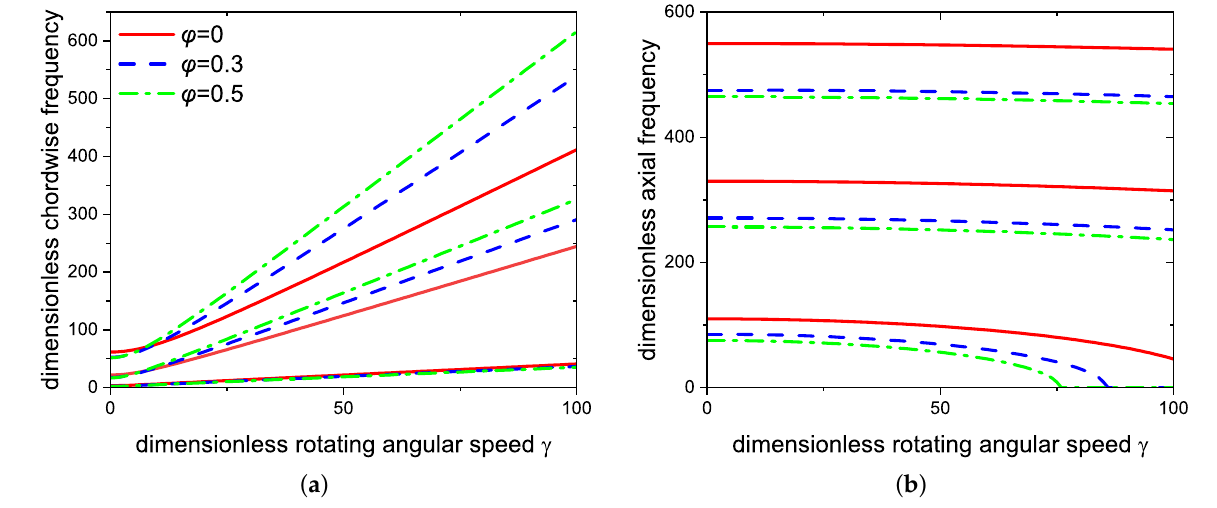
Figure 9. The first three-order dimensionless frequencies of rotating cantilever beams with different free end mass by the previous model: ( a ) Chordwise frequency; ( b ) Axial frequency.